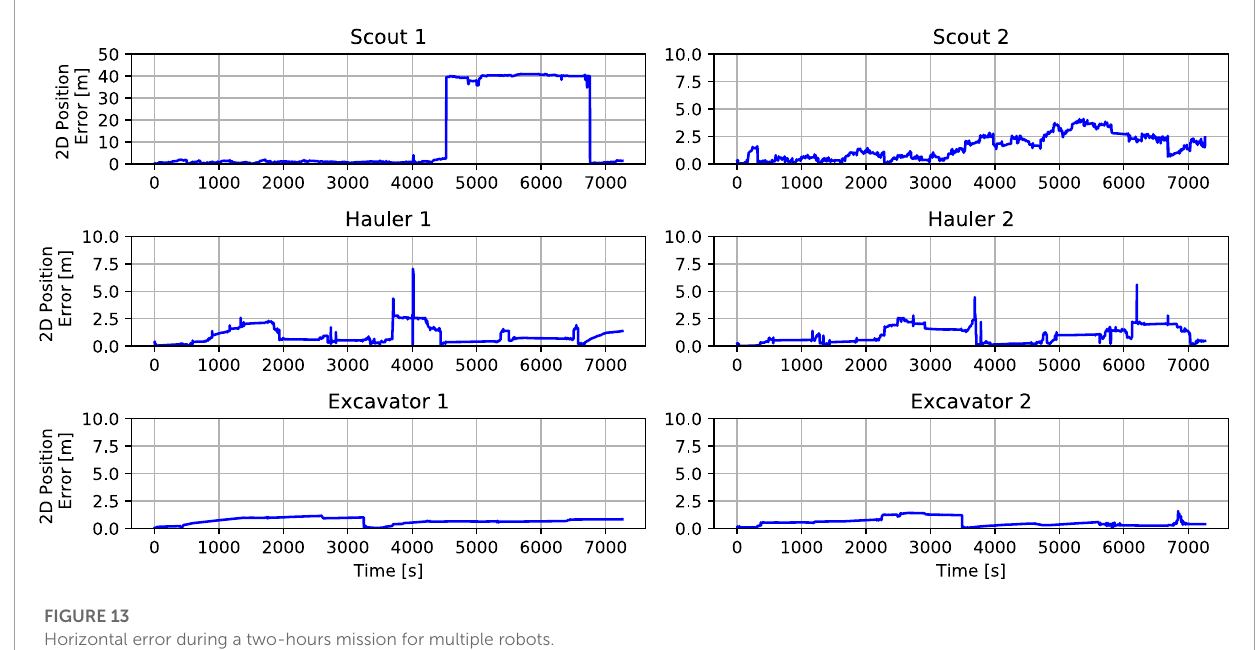
FIGURE 13 Horizontal error during a two-hours mission for multiple robots.